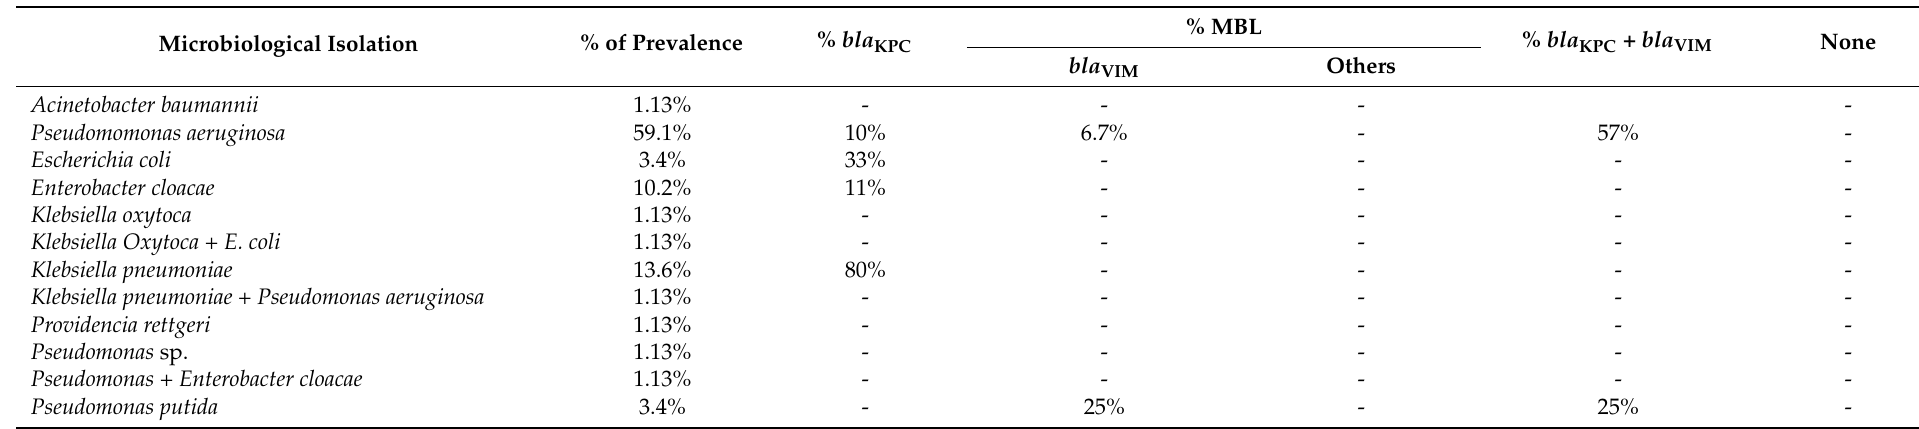
Table 3. Prevalence of all microorganism and carbapenemase genes detected in the molecular genetics laboratory for some of